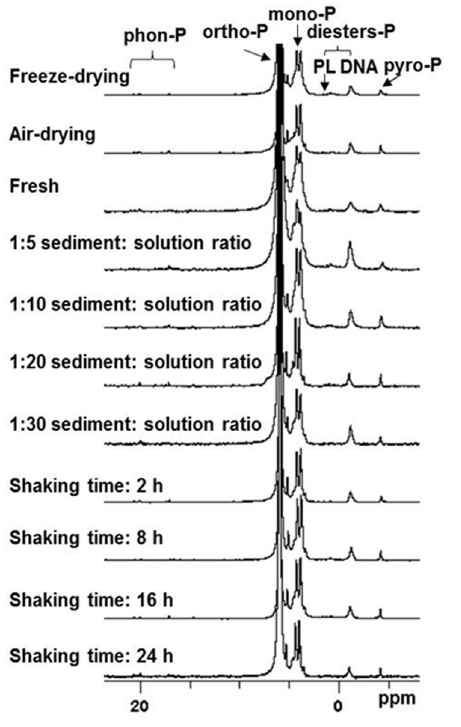
Figure 1. 31 P-NMR spectra of the sediment extracts after different analytical treatments.